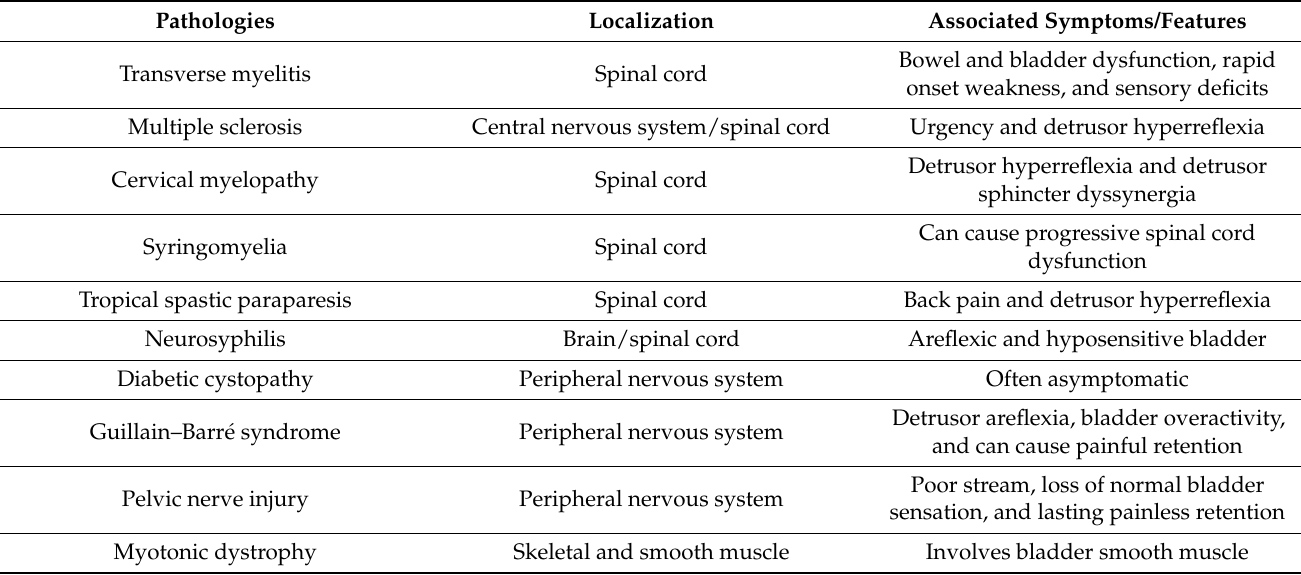
Table 1. Table of pathologies that may cause bladder control issues, their locations, and associated symptoms/features